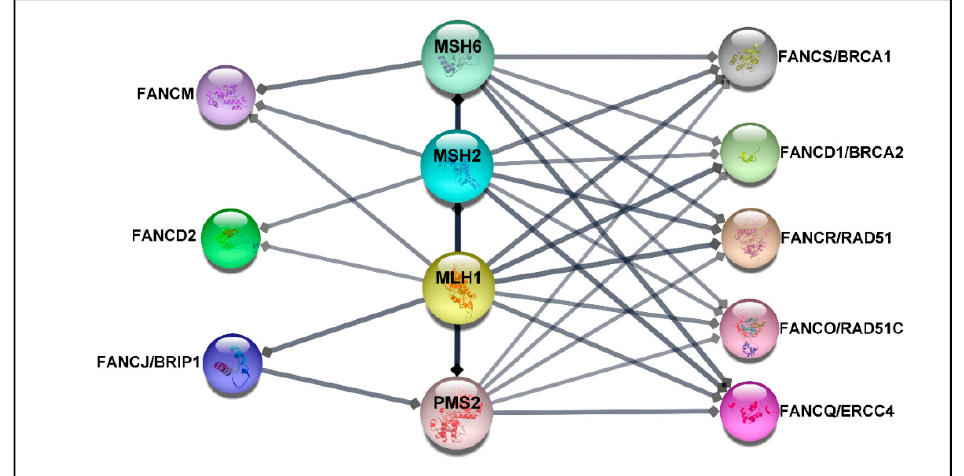
Figure 2. The protein–protein network. The protein–protein interaction (PPI) between MMR proteins comprising MLH1, MSH2, MSH6, PMS2, and 22 FA proteins was exported from the STRING database (high confidence (0.7)) [80] and visualized by using Cytoscape software, version 3.8.2 [81]. The association network shows that FANCS, FANCD1, FANCO, and FANCQ are linked with all selected MMR proteins, while FANCM interacts with MSH6, MSH2, and MLH1. FANCD2 is connected to MSH2 and MLH1, whereas FANCJ is associated with MLH1 and PMS2. The FA proteins without direct association with selected MMR proteins have been excluded.